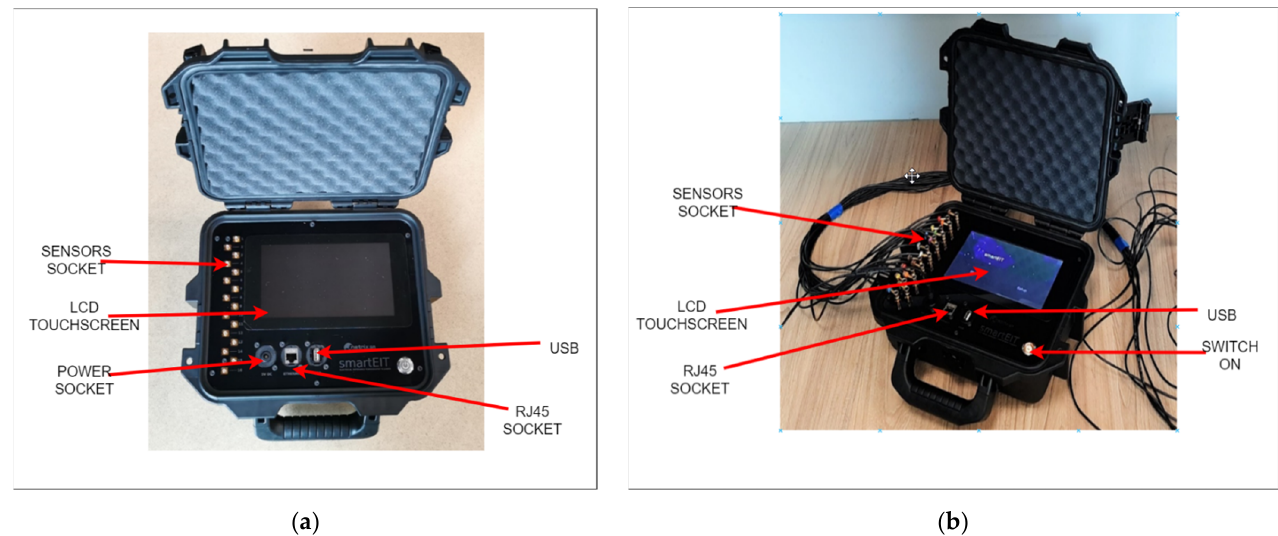
Figure 2. Photos showing the view of the SmartEIT scanner placed in the housing on the left ( a ) and the device connected to the probes and working—on the right ( b ).